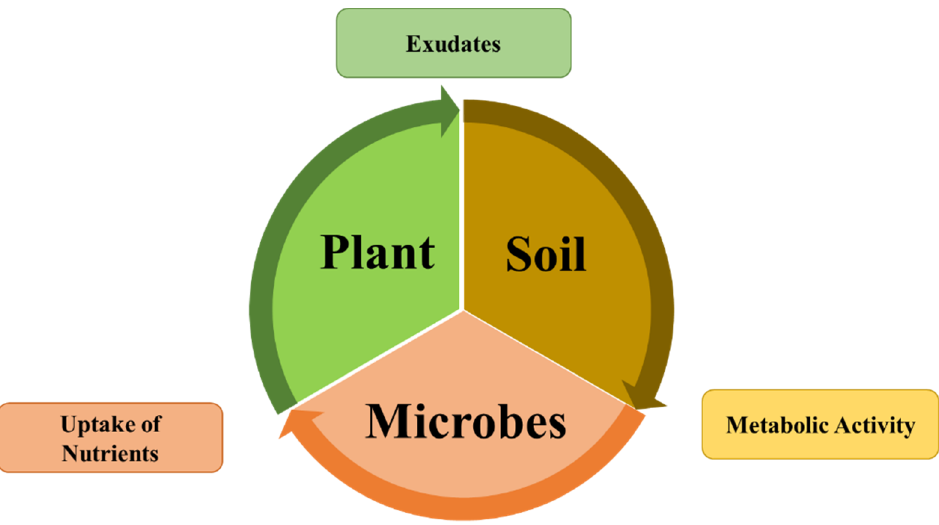
Figure 2. Interconnection between the plant, soil, and microbes. Plant roots secrete a prodigious diversity of organic nutrients and signals that attract microbes. Consequently, microbes breakdown the complex nutrients from complex to simple available forms to plants.